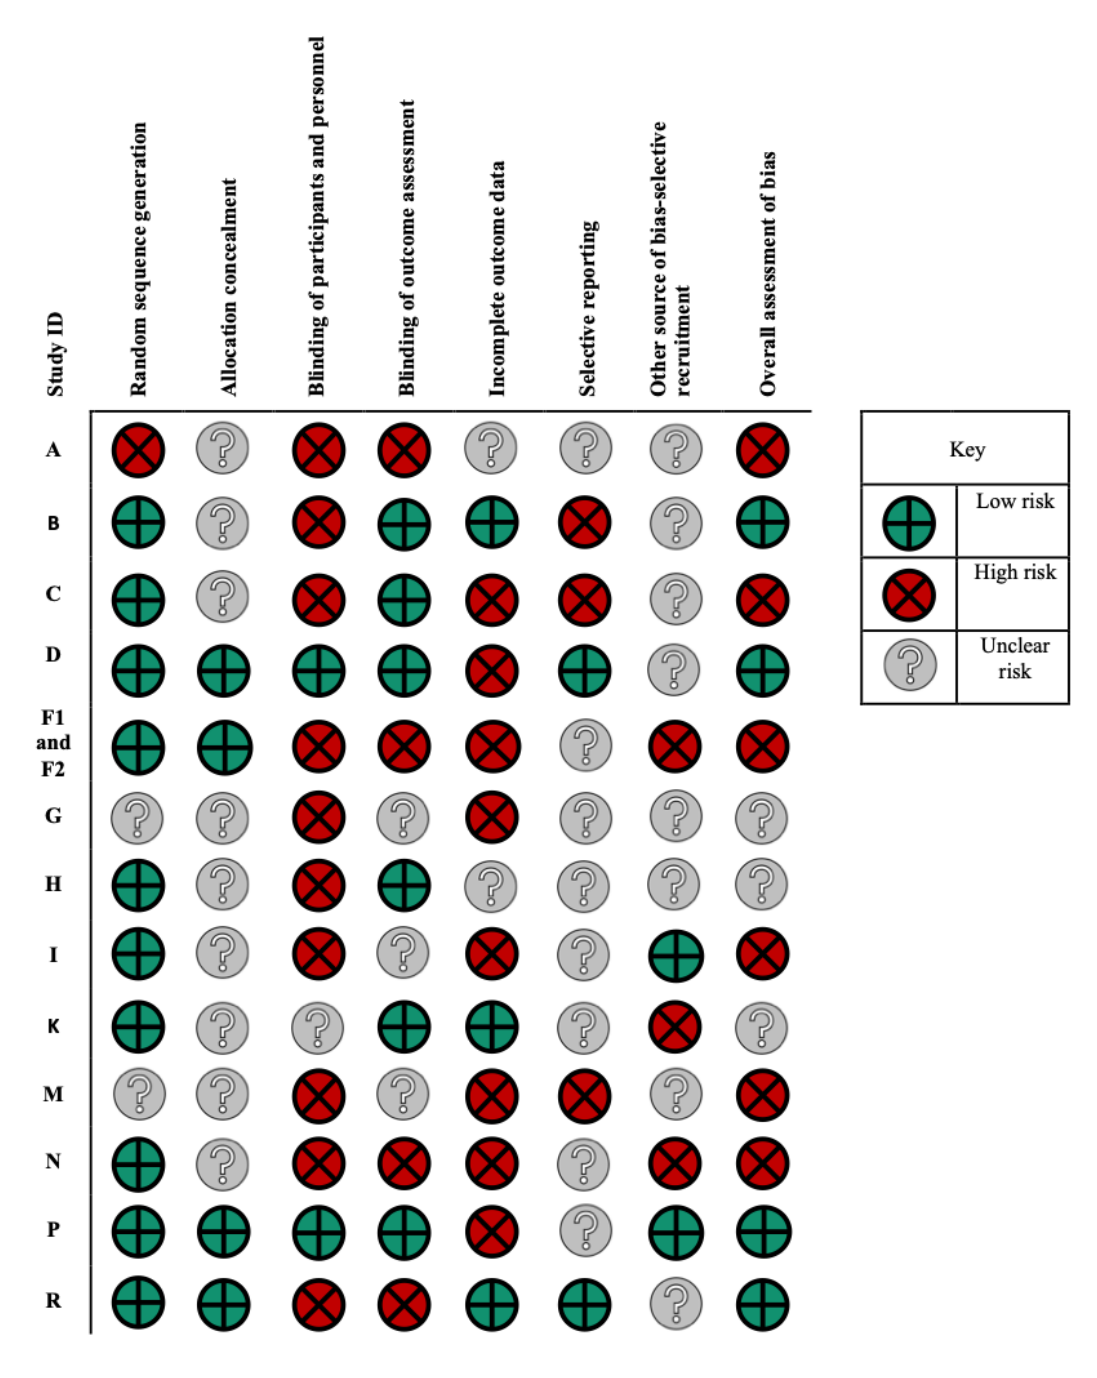
Figure 2. Risk of bias table for randomized controlled